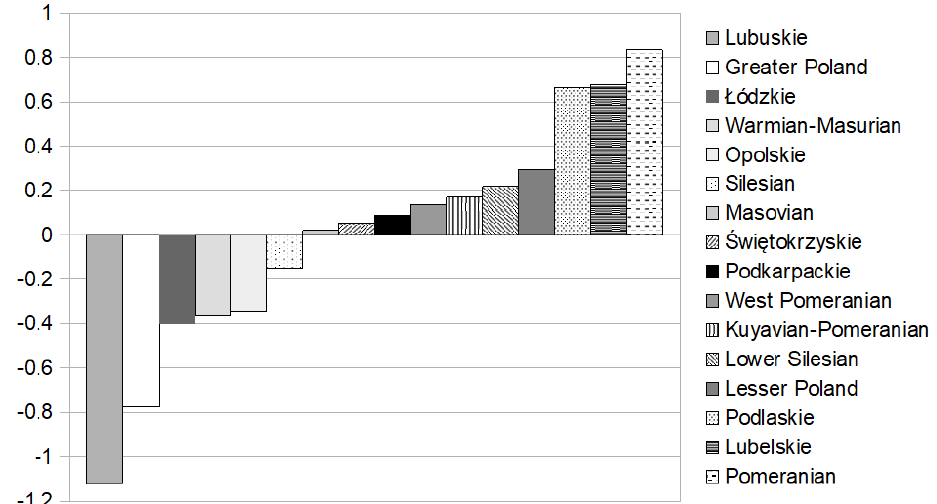
Figure 2. Comparison of Polish voivodeships with respect to the increasing value of the W B indicator. Source: Authors’ calculations. Source: Authors’